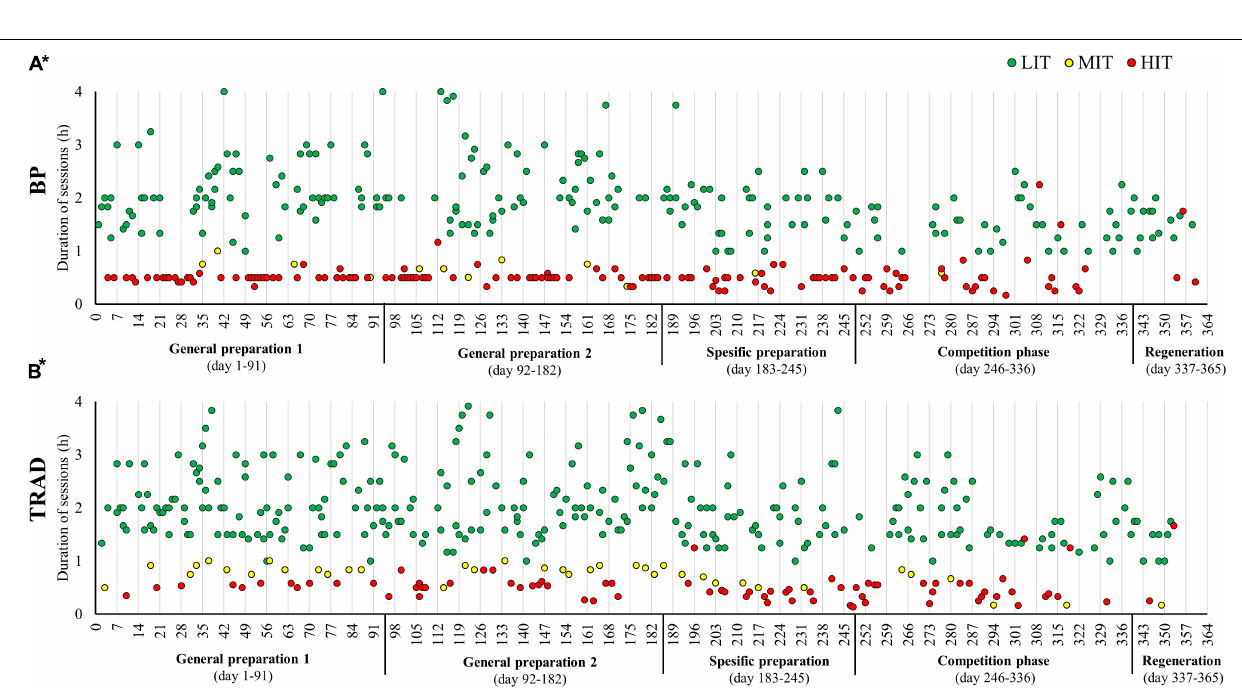
Frontiers in Physiology |